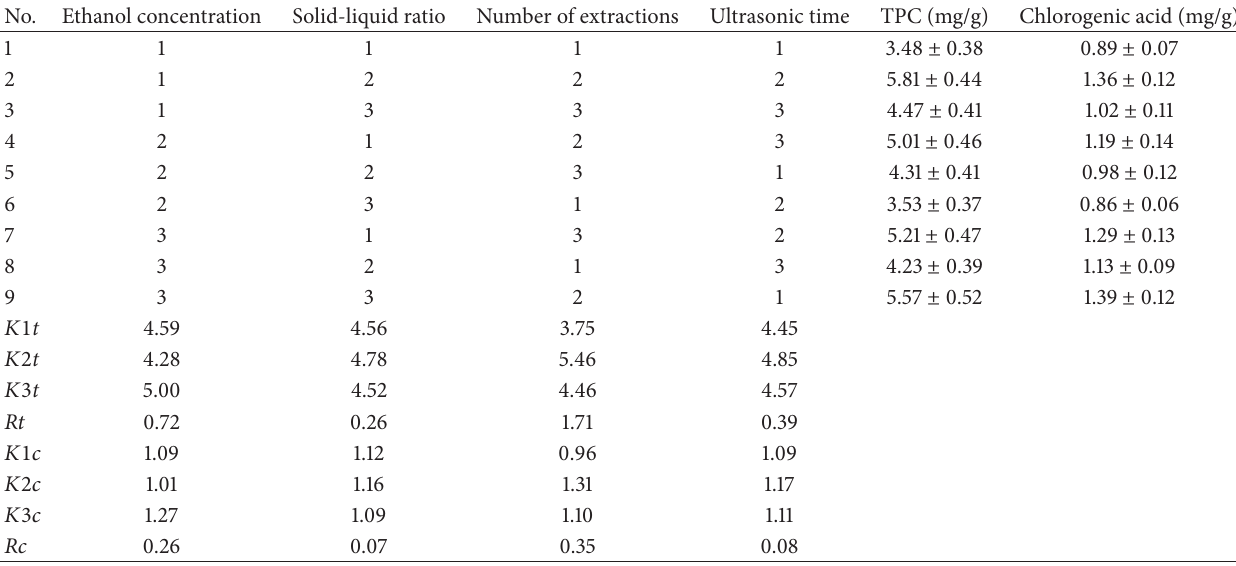
Table 1: Orthogonal design and experimental results.